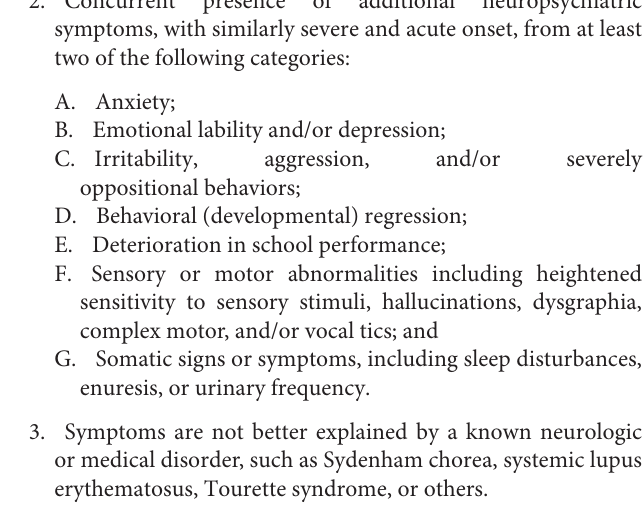
TABLE 1 | Diagnostic criteria of PANDAS, PANS, CANS, and